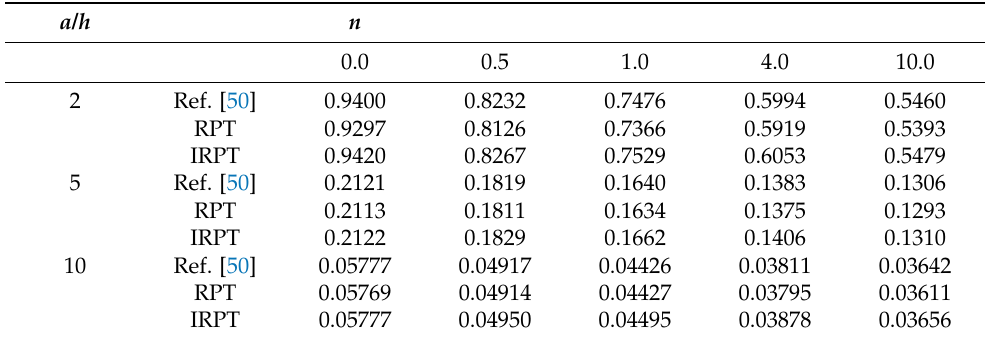
Table 3. Dimensionless fundamental frequencies of Al/Al 2 O 3 functionally graded t square